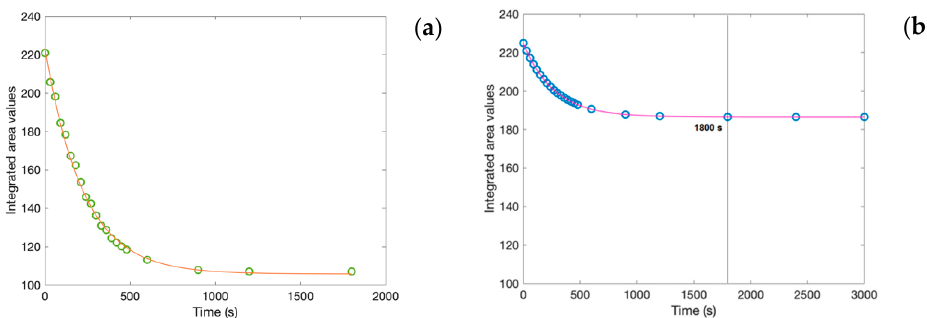
Figure 3. Integrated area values of the whole investigated spectra as a function of time for: ( a ) creatine aqueous solution; ( b ) creatine aqueous solution in the presence of trehalose.